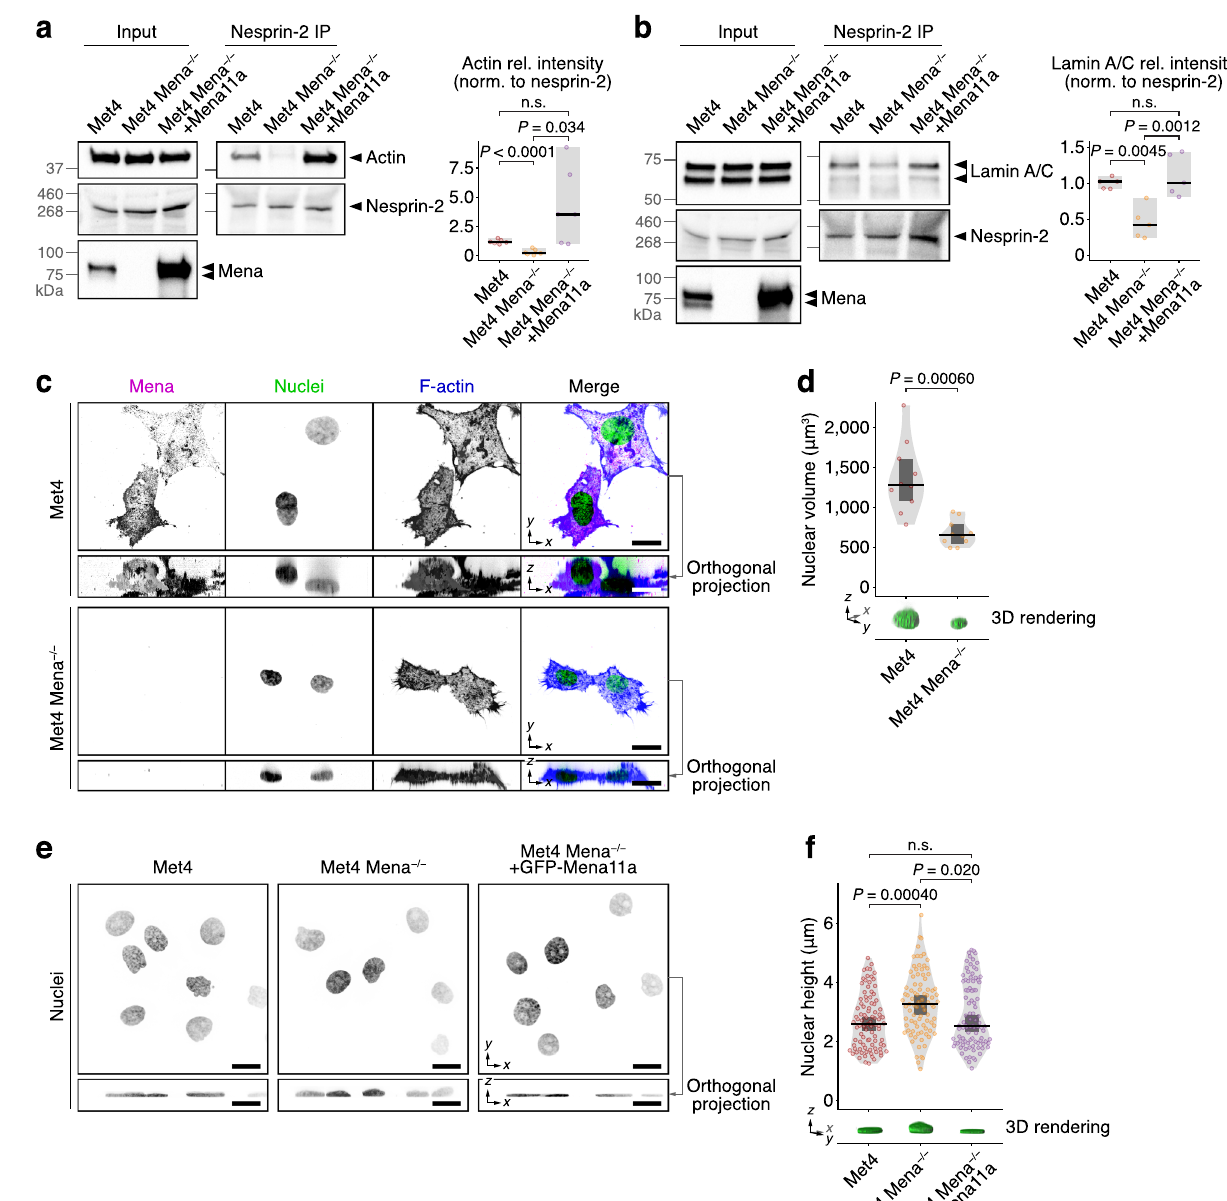
Fig.3|Menaisrequiredfornesprin-2linkstoactinandlaminA/Candregulates nuclear morphology. a , b IP analyses of nesprin-2 protein complexes in Met4 cells, Mena-depleted Met4 cells (Met4 Mena − / − ) and Met4 Mena − / − cells with Mena11a re-expressed (Met4 Mena − / − +Mena11a). Actin ( a ) and lamin A/C ( b ) were detected by western blotting; respective densitometric intensities were normalised (norm.) to nesprin-2 and expressed relative (rel.) to Met4 cells (right panels). Black bar, median; light grey box, range. Statistical analysis, Welch ’ s one-way ANOVA with two-stage Benjamini – Krieger – Yekutieli correc- tion ( n = 6 independent experiments) for ( a ), one-way ANOVA with Tukey ’ s correction ( n =5 independent experiments) for ( b ). c Spinning-disk confocal imaging of Met4 cells and Met4 Mena − / − cells in 3D collagen matrix. Ortho- gonal projections ( xz ) were extracted from 3D brightest-point projections. Nuclei were detected using DAPI; F-actin was detected using phalloidin. Inverted lookup tables were applied. Images are representative of two inde- pendent experiments. Scale bar, 20 μ m. d Quanti fi cation of nuclear volume of